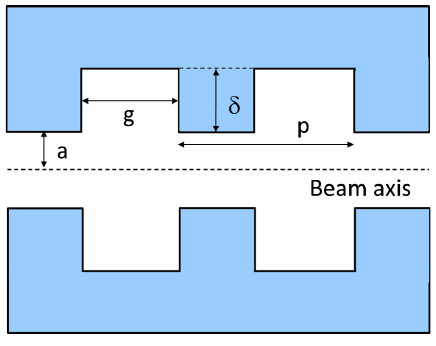
FIG. 3. Section of the geometry of a corrugated plate. The most important parameters for the wakefield calculations are also indicated.